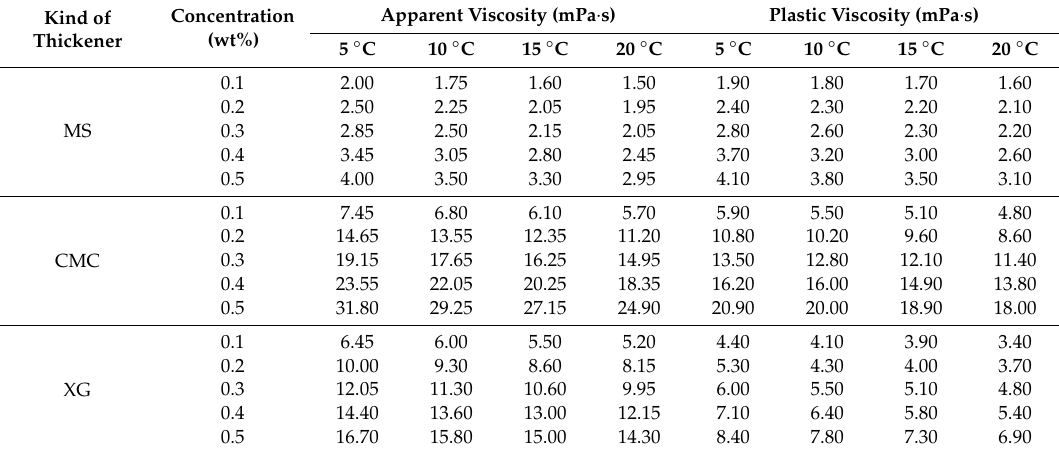
Table 1. Apparent and plastic viscosities of solutions under di ff erent temperatures. Kind of